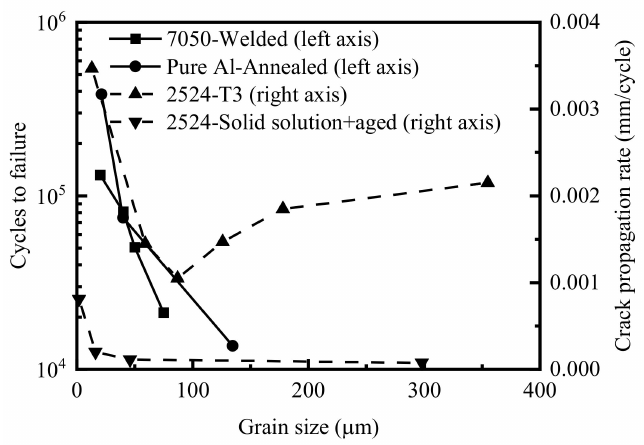
Figure 15. Solid lines: relationship between number of cycles to failure and grain size of welded AA7050 rolled plates under bending fatigue test [115], and as-annealed pure Al under uniaxial fatigue test at room temperature with a stress amplitude of 100 MPa [116]; dashed lines: relationship between crack propagation rate and grain size of T3-treated AA2524 [117] and solutionised and aged AA2524 at room temperature and stress ratio of 0.1 with loading frequency of 10 Hz